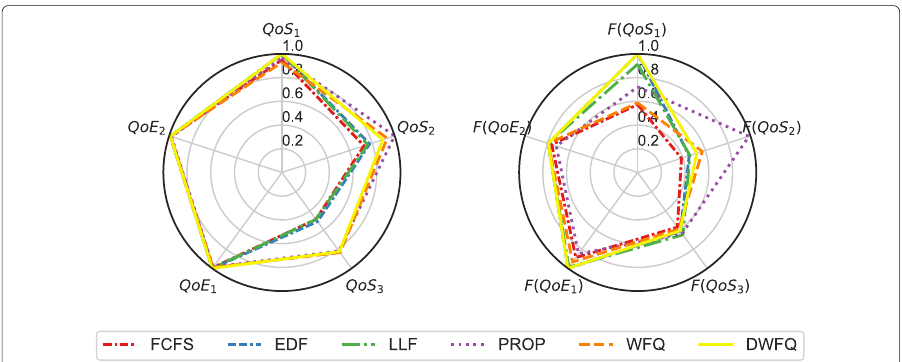
Below the box plots in Fig. 7, the fairness index F is depicted for each metric and policy. As can be seen, only the proposed DWFQ policy is among the best three for each metric, whereas EDF and LLF achieve a high fairness index for most metrics except QoS 2 . Again, this tracks back to the time division behavior of both policies. Figure 8 compares the mean quality of service and experience obtained with the fairness index. The spider plots clearly show that PROP, WFQ and DWFQ outperform the other three policies in terms of mean